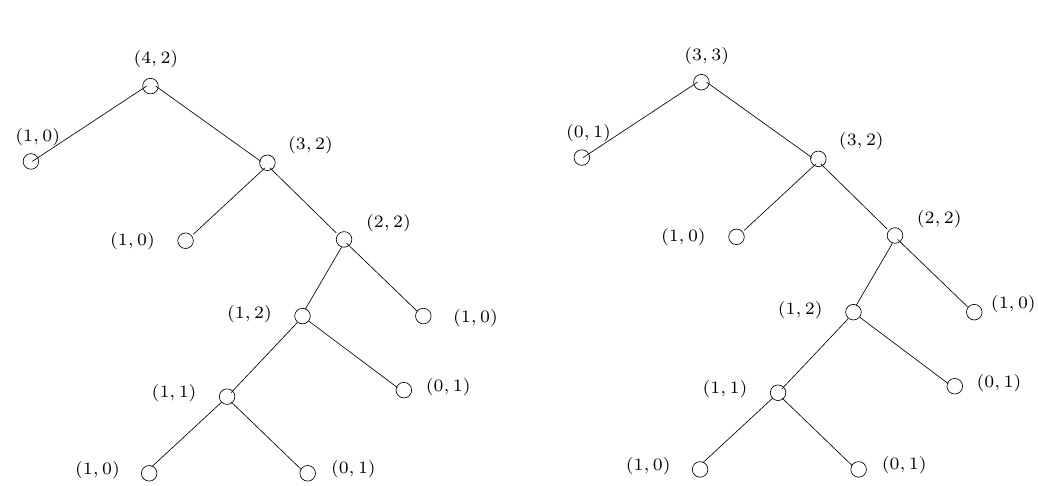
Figure 2: the tree of Figure 1 with two different JL -labelings, both (obviously) essentially different from each other, but also (not so obviously, in one case) from the labeling in Figure